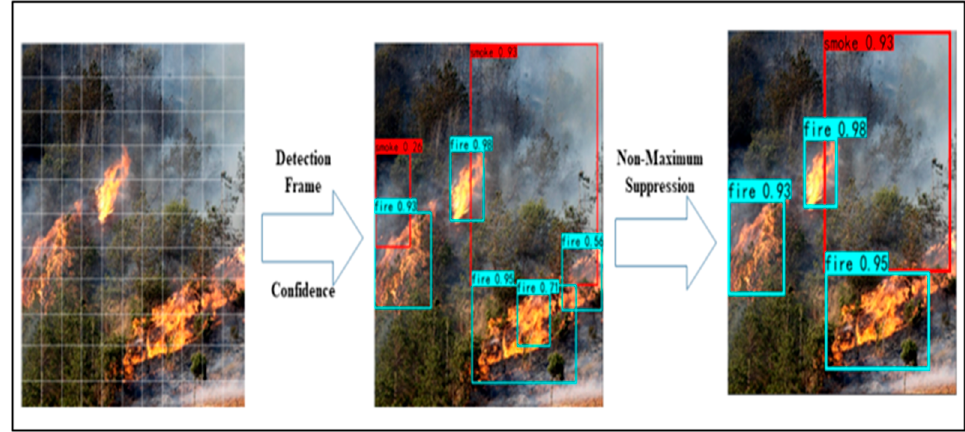
Figure 5. Input image is divided into S × S grids, and each grid predicts three bounding boxes and con fi dence scores. Afterward, the optimal bounding box is selected using an NMS method.